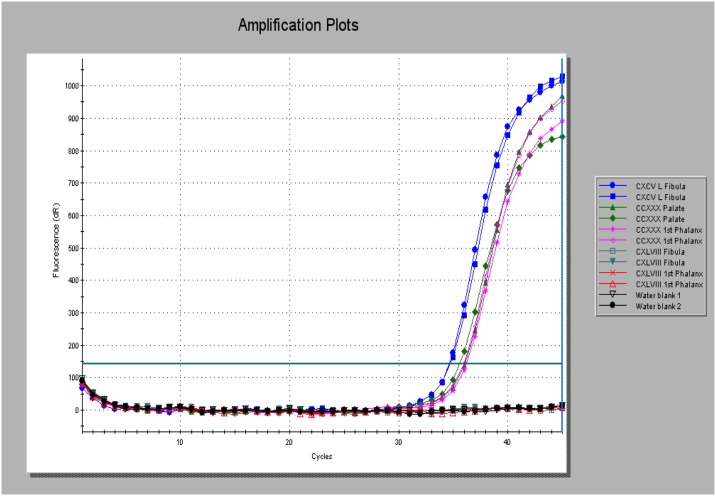
Amplification plots of the single-copy 18kDa gene PCR product reported with a specific JOE-labelled fluorogenic probe.Products were generated from extracts prepared from SkCXCV (left fibula, blue traces) and SkCCXXX from two extracts (palate, green traces) and first phalanx (fuchsia pink trace). SkCXLVIII was negative using this PCR method, as were the two template blanks run in parallel (black traces).